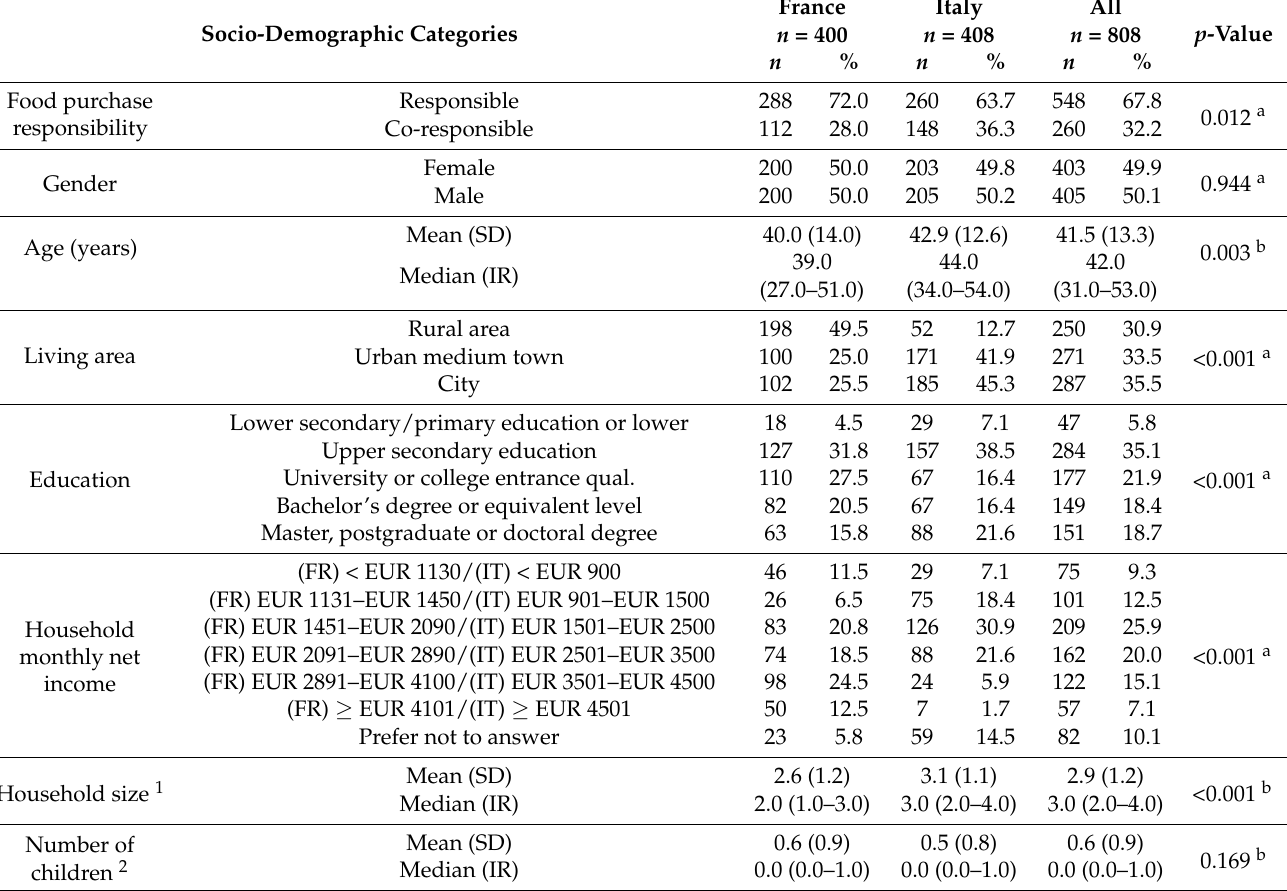
Table 1. Sample demographic and socio-economic characteristics, number ( n ), percentage (%), mean and standard deviations (SD), median and interquartile range